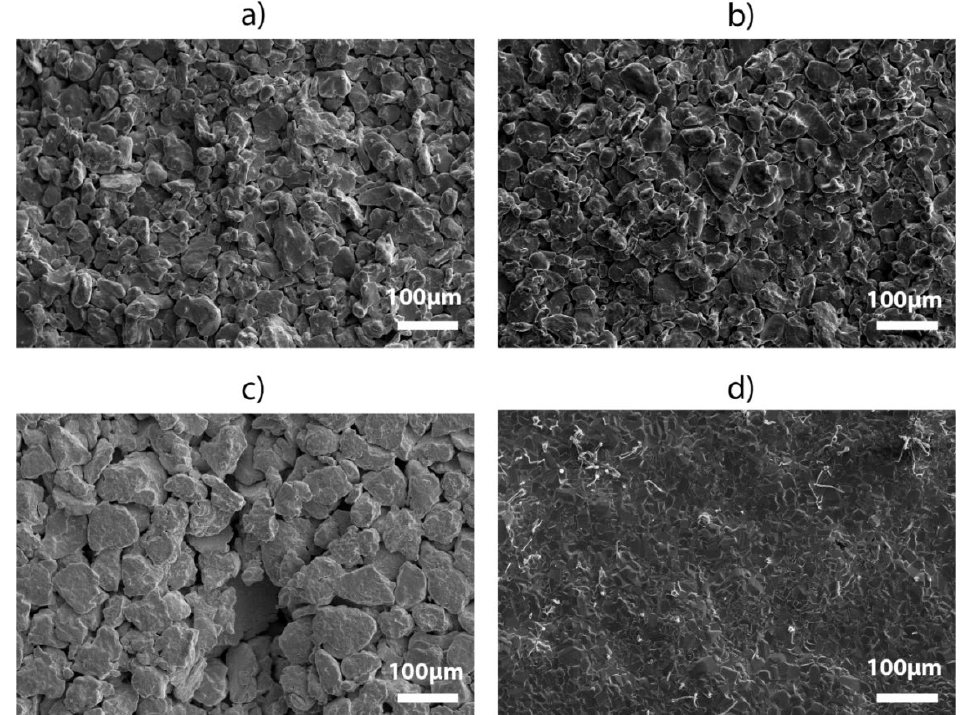
Figure 1. SEM micrographs registered for ( a ) sample A, ( b ) sample B, ( c ) sample C, ( d ) sample D.